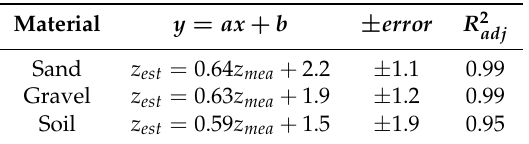
Table 3. Linear polynomials fitted to the scatter graph of Figure 8 where z est is the estimated depth and z mea is the measured depth. This can be used as calibration equations to correct for the deviation of the estimated depth from the measured